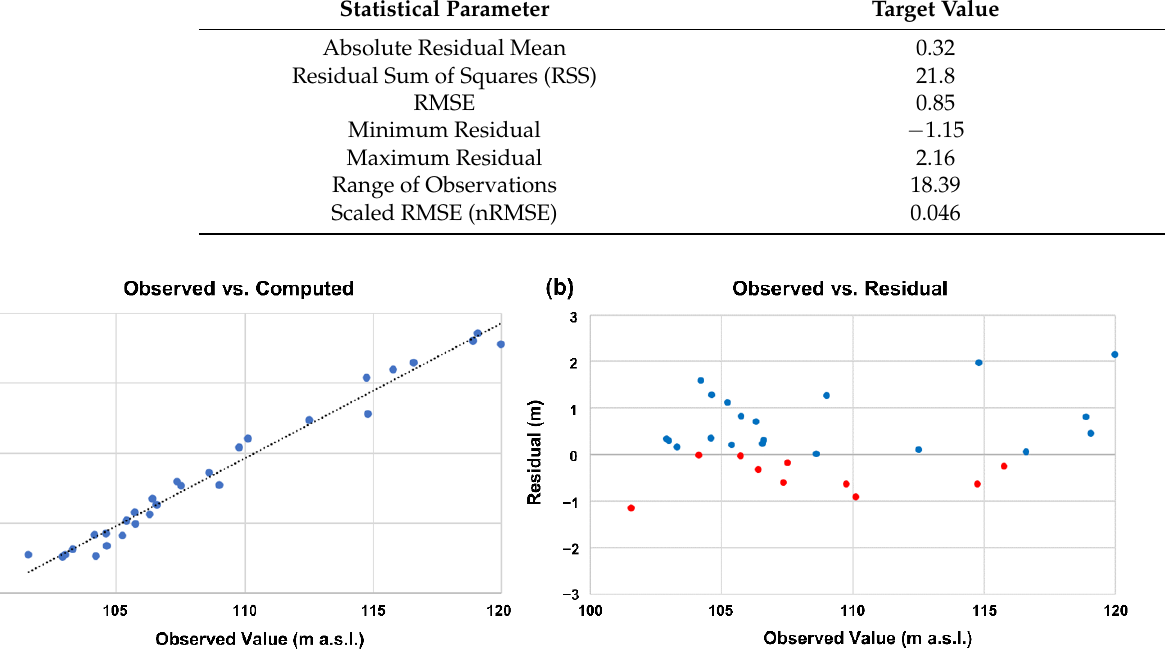
Figure 8. Comparison of ( a ) observed (m a.s.l.) vs. computed (m a.s.l.) values and ( b ) observed values (m a.s.l.) vs. residuals (m).